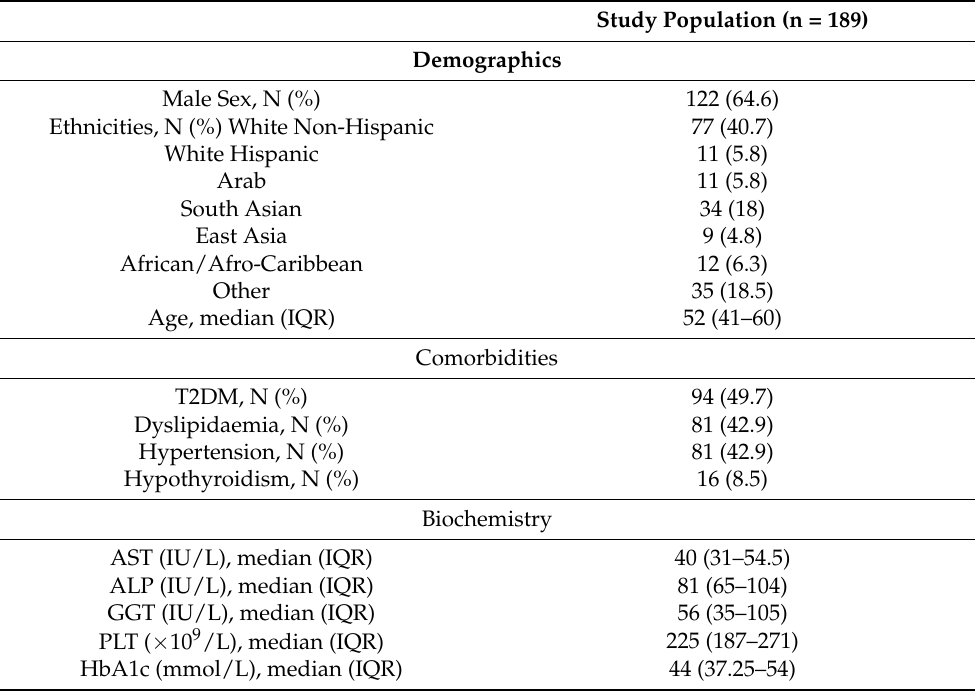
Table 1. Clinical and demographic features of the study